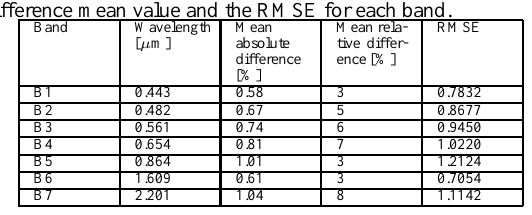
Table 1: Landsat-8 scene TOA reflectance absolute and relative difference mean value and the RMSE for each band.